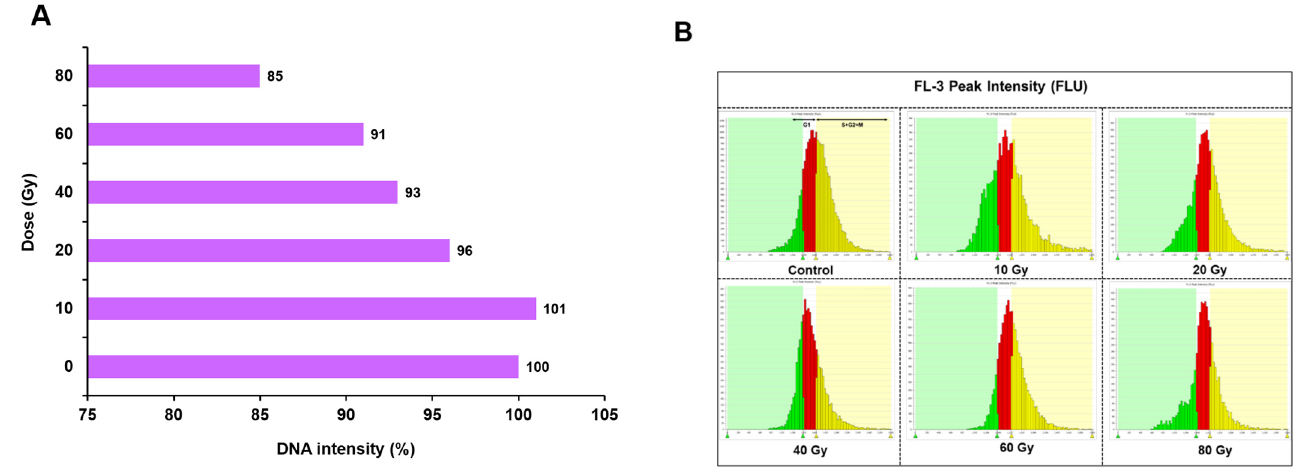
Figure 3. High-throughput-cell-analyser (HTCA)-based nuclear DNA content estimation and cell cycle analysis in protocorm-like bodies (PLBs) of Dendrobium under different gamma radiation treatments. PLBs of Dendrobium ‘Emma White’ were irradiated with gamma ray doses of 10, 20, 40, 60 and 80 Gy and incubated at 22 ± 2 ◦ C and 65–70% relative humidity with 16 h photoperiod. After five months of treatment, nuclei were isolated from irradiated and control PLBs to estimate the nuclear DNA content based on the average fluorescence intensity of nuclei generated by HTCA, ( A ) Percentage of DNA intensity calculated based on fluorescence intensity of nuclei under different radiation treatments of 10, 20, 40, 60 and 80 Gy, including control using HTCA, ( B ) FL-3 fluorescence intensity histogram of nuclei isolated from PLBs, incubated with propidium iodide overnight at 4 ◦ C in dark conditions. Gate between 0–1200 indicates dead cells (green), 1201–1600 live non-dividing cells in G1 phase (red) and 1601–2800 dividing cells in S, G2 and M phase (yellow) of cell cycle. The 488 nm laser-excited propidium iodide dye (FL-3) intercalates DNA and facilitates enumeration of DNA per nuclei